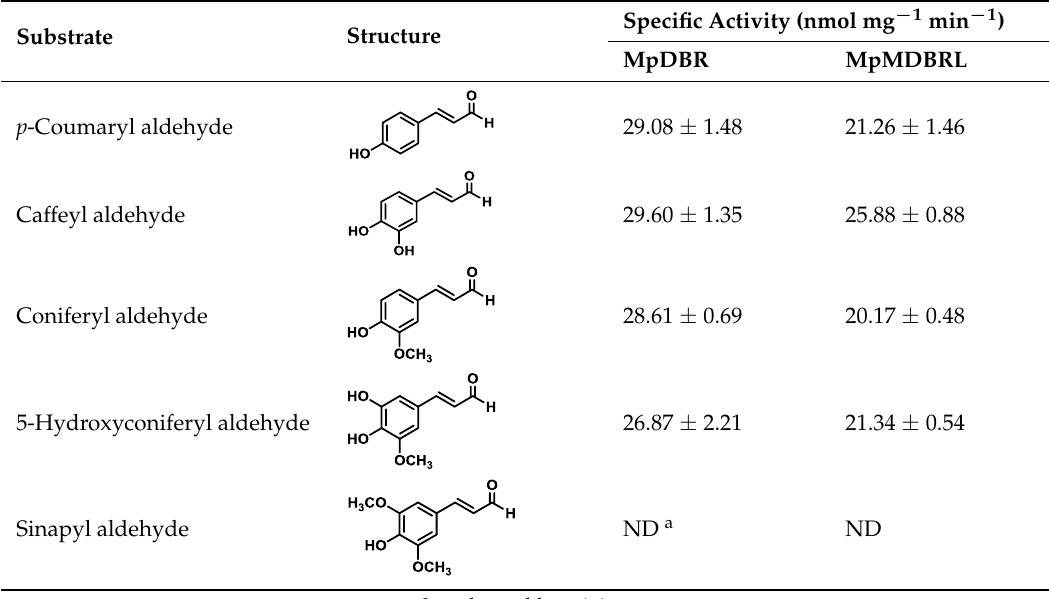
Table 1. The substrate specific activity of MpDBR and MpMDBRL from M. paleacea . Substrate